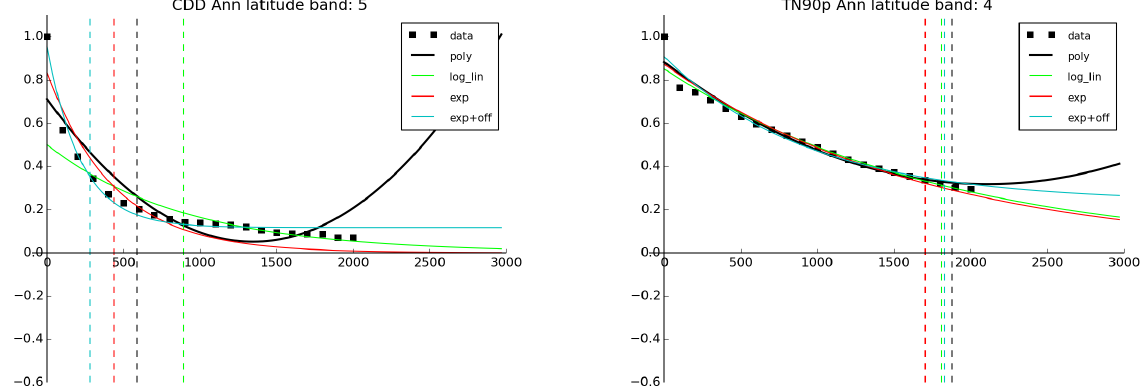
Figure 11. The binned inter-station correlation coefficients against distance for left CDD (consecutive dry days) and right TN90p ( T min > 90th percentile) along with the curves from all four fitting methods. The vertical dashed lines are the derived decorrelation length scales.